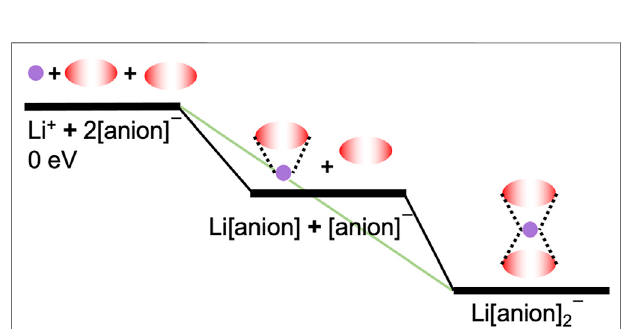
FIGURE 2 | Comparison of differential and integral analyses for Li solvates with a symmetrical anion. Bidentate binding is illustrated for one and two coordinating anions. Energy levels are indicated by the black horizontal bars where the starting individual components have 0 eV as a reference and the Li solvates have < 0 eV. The differential energies are represented by the solid black lines and the integral energy is represented by the diagonal green line that connects the 0 eV state with the Li[anion] 2 − 1 solvate at the lowest energy state.